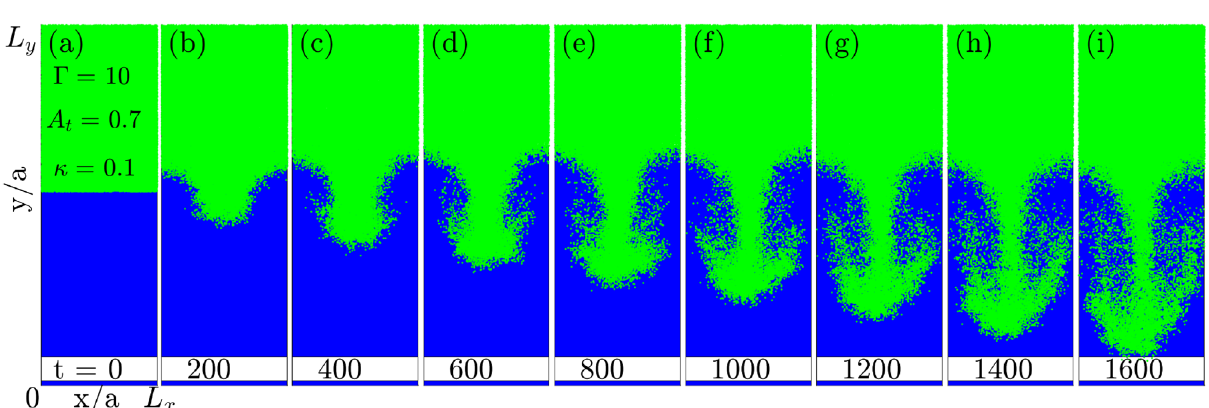
Figure 2. Time evolution of single-mode RTI. ( a ) The initial step density profile with L y = 10 L x . ( b – i ) are 1 snapshots of growth of RTI at time intervals of 200 ω − pl each. The rise of bubbles (blue-coloured) of light fluid due to buoyancy and fall of the spike (green-coloured) of heavy fluid due to gravity is observed. From ( e ) onward, the nonlinear mushroom cloud formation due to secondary KHI is